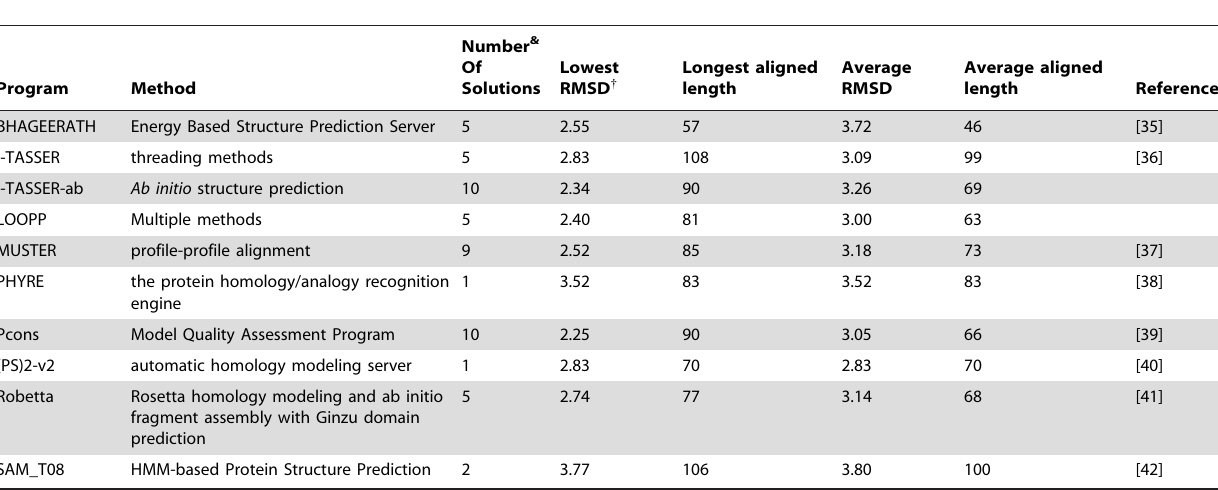
Table 3. Details of models built by different 3D structure prediction